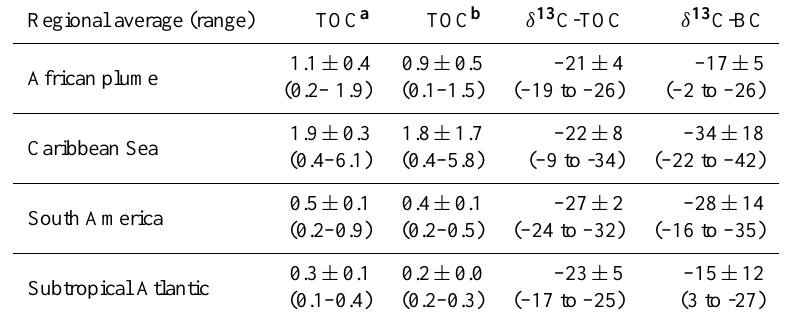
Table 2. Average regional total organic carbon concentrations and ranges (µgm − 3 ) for the TOT methods (TOC a ) and CTO-375 (TOC b ) methods and the δ 13 C value (‰) for the total organic carbon and black carbon determined by the CTO-375 method.